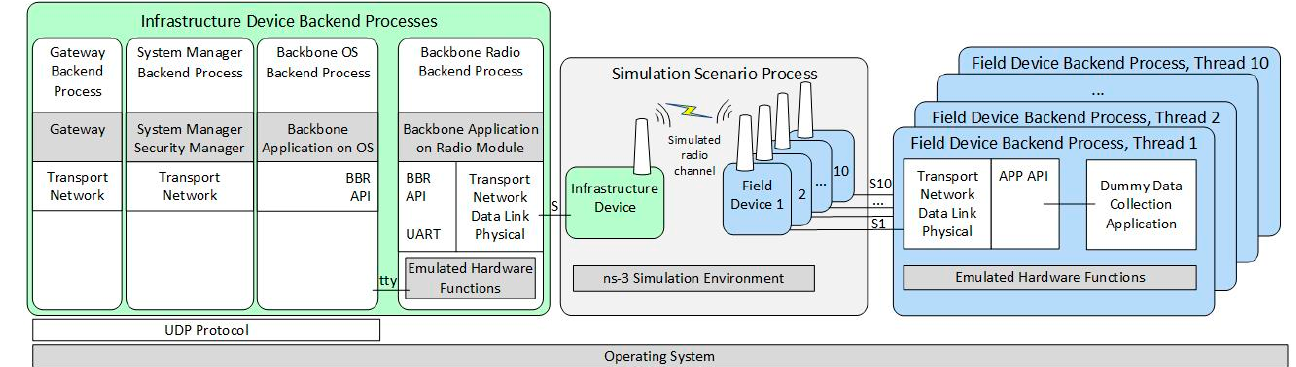
Figure 9. Extended simulated scenario architecture.